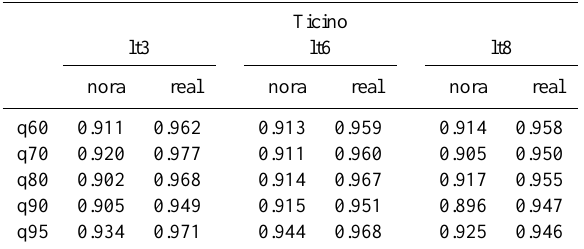
Table 3. ROC area for NORA and REAL-C2 forecasts of the Ticino catchment, with lead times 03:00, 06:00 and 08:00, for the threshold quantiles q60 to q95.